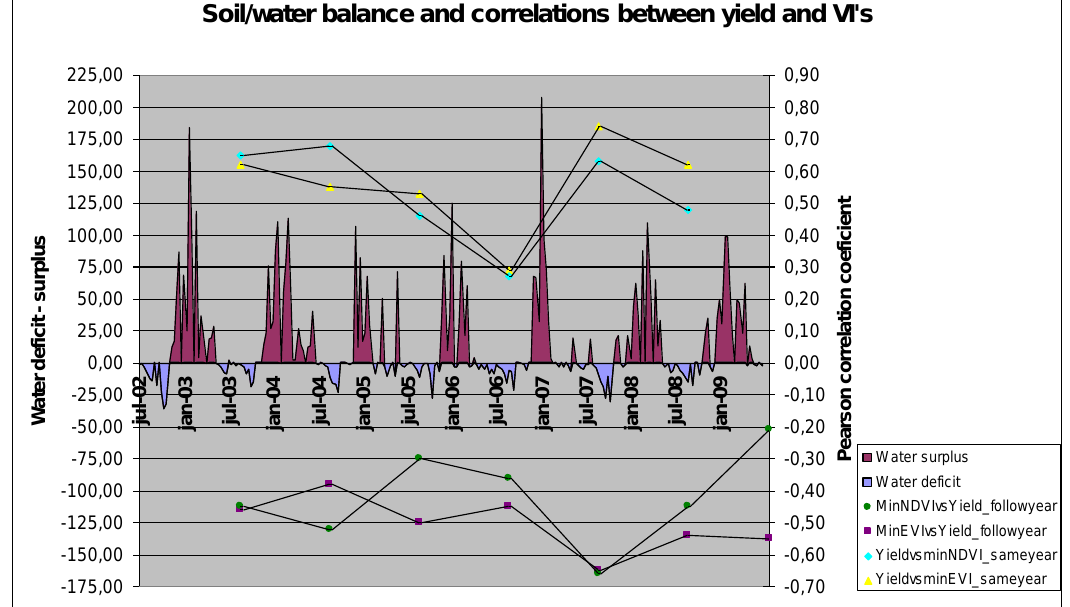
Figure 8. Water balance for Guaxupé location and Pearson correlation coefficients from 2002 to